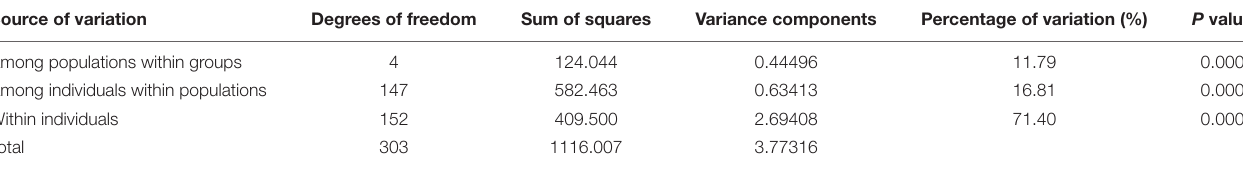
TABLE 4 | Analysis of molecular variance (AMOVA) of 10 microsatellite loci in five C. nobilis populations. Source of variation Degrees of freedom Sum of squares Variance components Among populations within